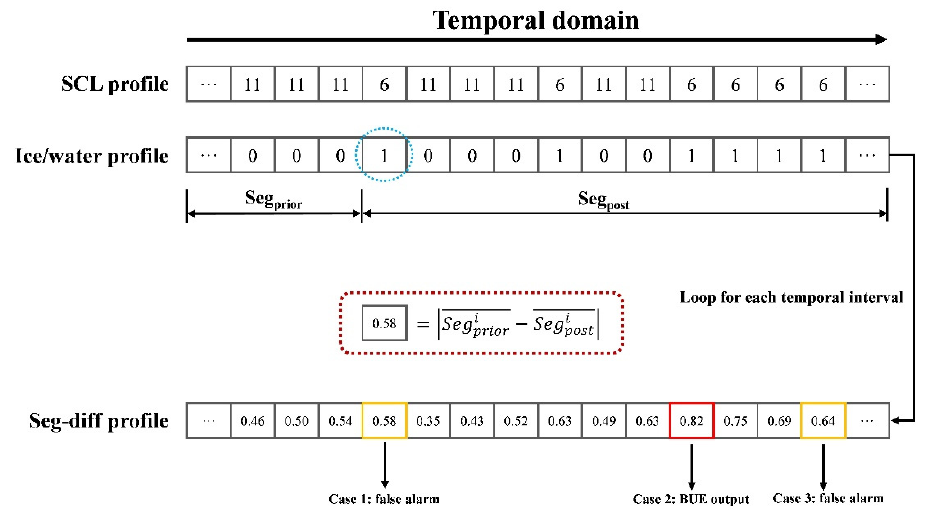
Figure 3. Illustration of the proposed “max-seg-difference” algorithm for BUE identification.